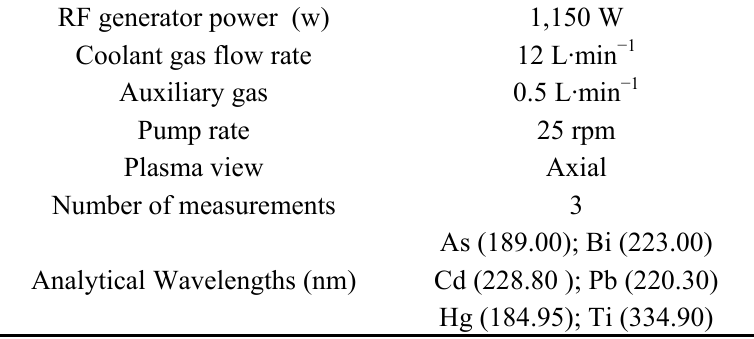
Table 1. Operation condition parameters for